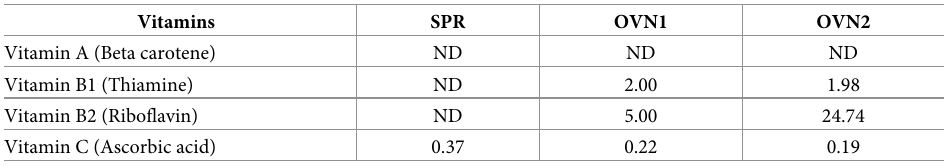
Table 4. Concentration of vitamins in the (mg 100g -1 ). Vitamins